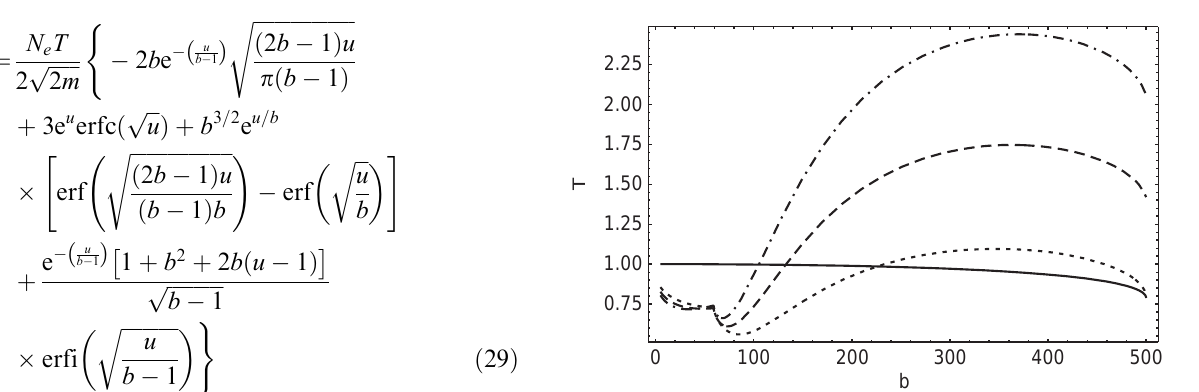
Fig. 5. Same as Fig. 3 but for the temperature